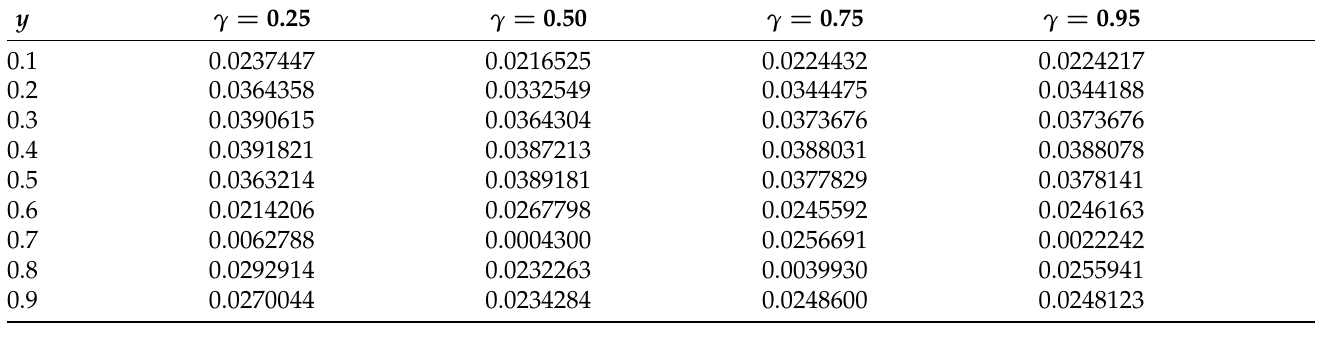
Table 6. Absolute errors of Example 2 for α = 0.05, at various connections.